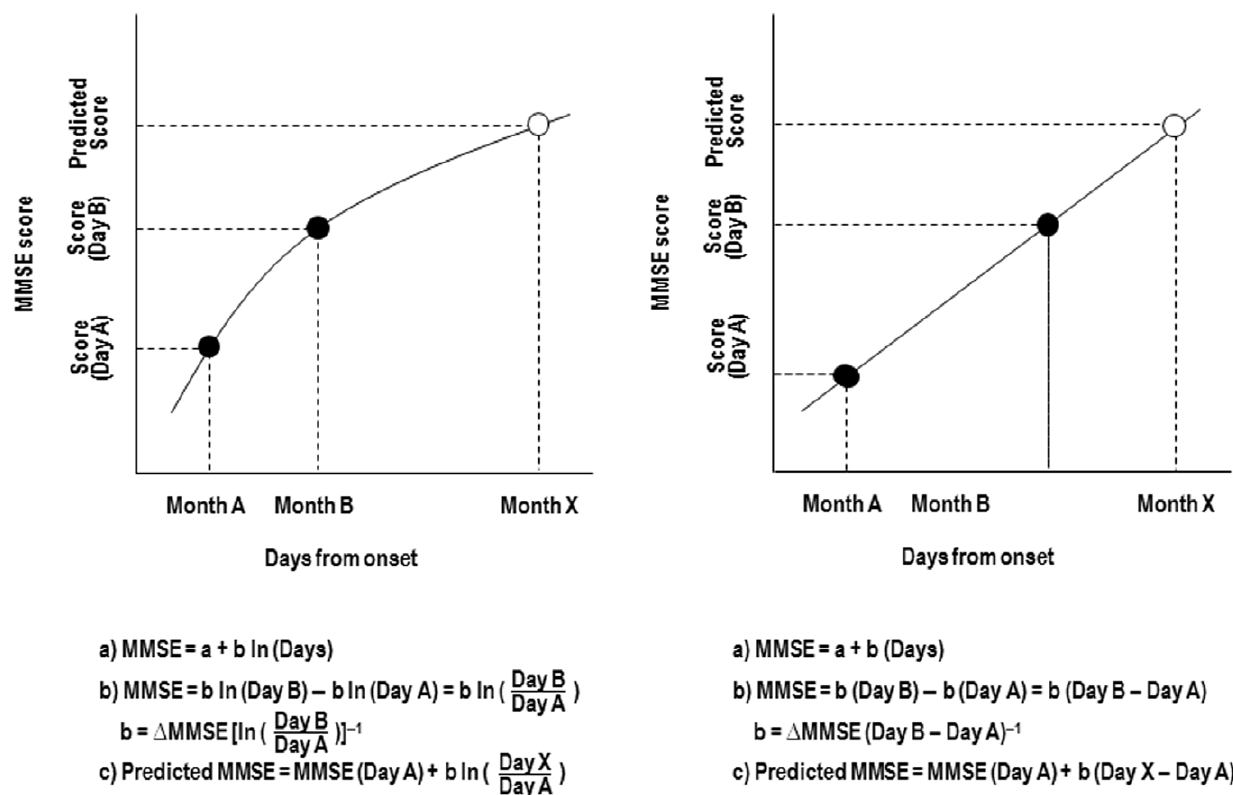
Figure 1. Logarithmic modeling and linear regression modeling. A generic structure of logarithmic (A) and linear regression (B) modeling is given in a simple formula (independent variable=days from onset). MMSE: Mini-Mental State Examination; Ln: natural logarithm. D MMSE indicates change in MMSE scores between Day A and Day B. X can be calculated with this formula.